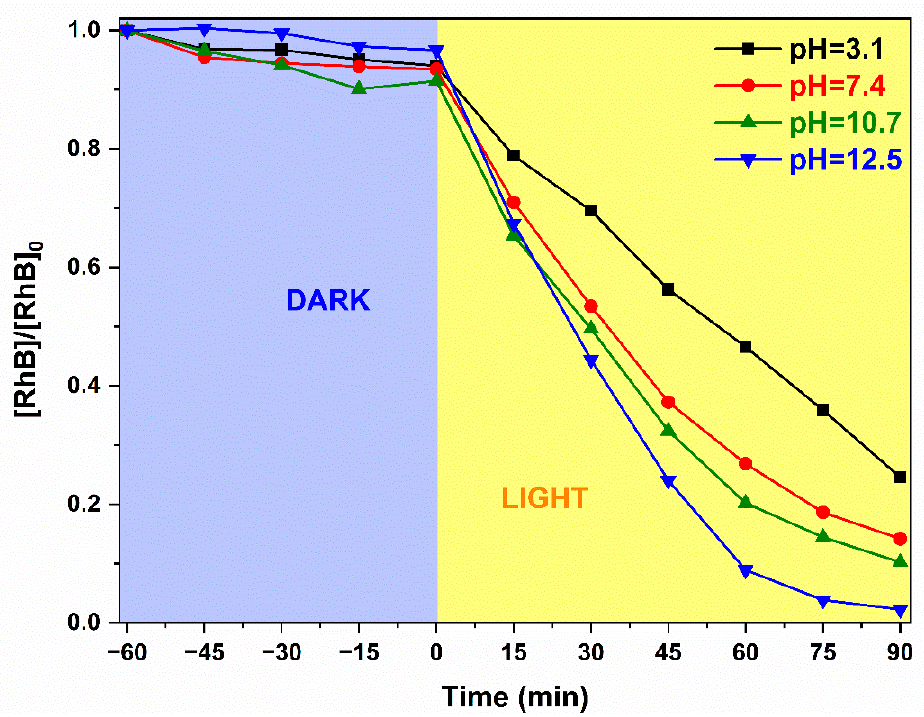
Figure 7. The influence of the pH value of the RhB dye solution in Milli-Q water on the photocatalytic degradation efficiency in the presence of rGO@TiO 2 /CN hybrid as photocatalyst. Table 3. Photocatalytic degradation of RhB dye in aqueous solution (Milli-Q) at different pH values.